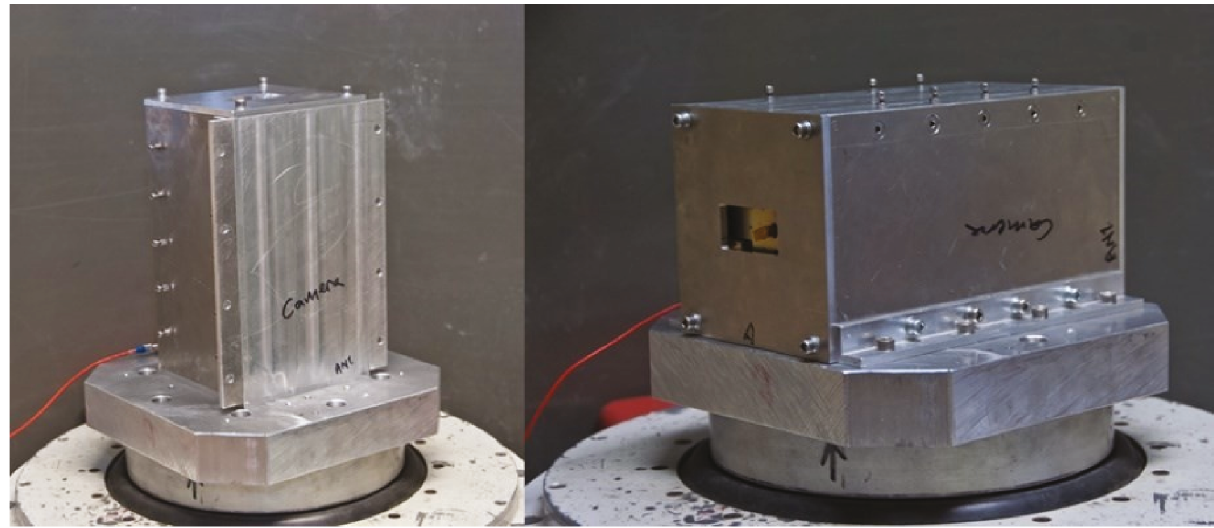
Figure 14: Vibration campaign test